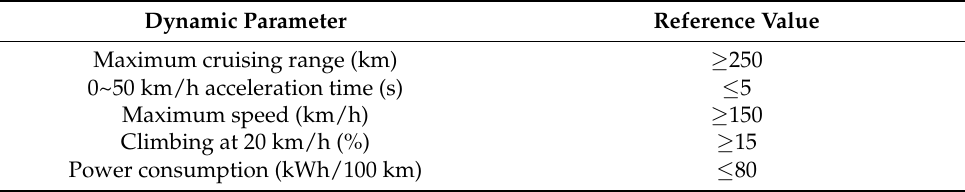
Table 2. Power performance requirements for pure electric